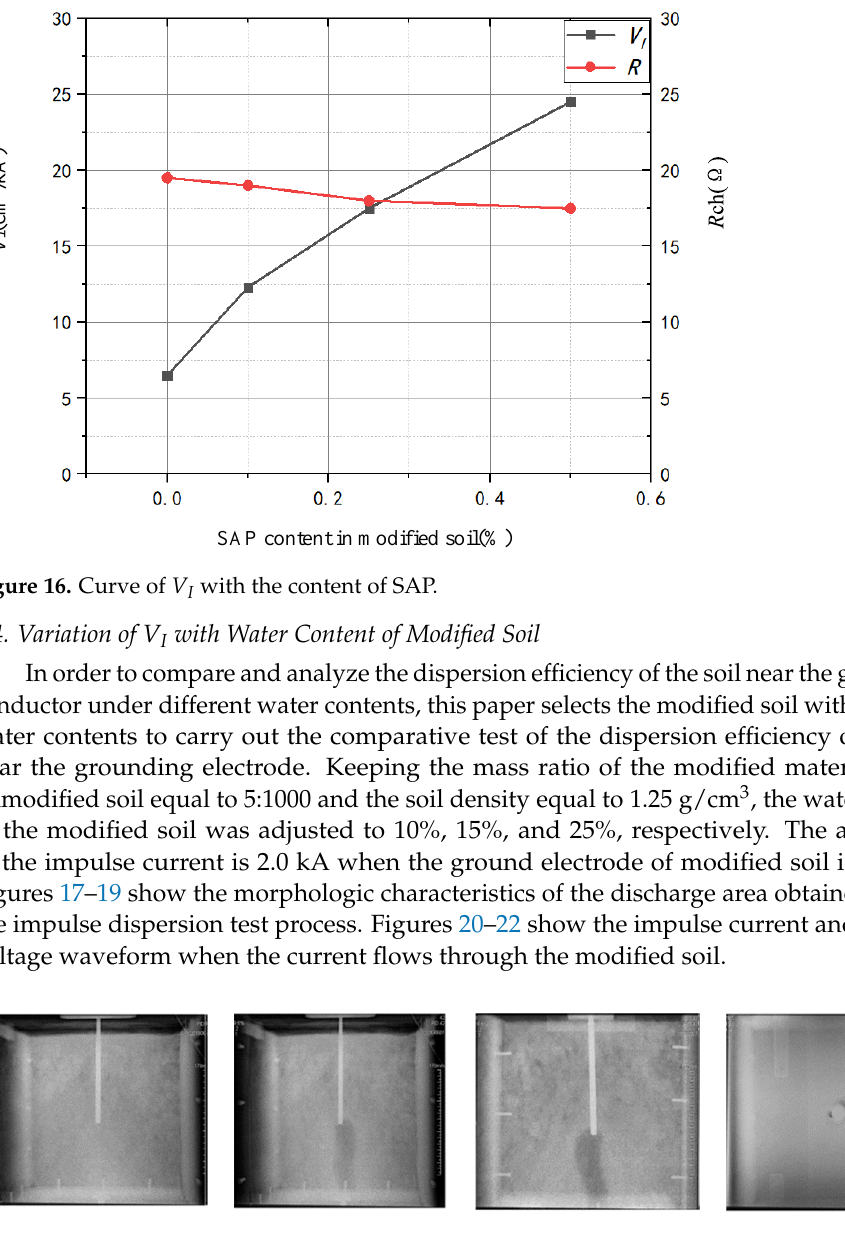
( d ) Figure 18. Images of modified soil with water content of 15%: ( a ) Before breakdown; ( b ) front view; ( c ) side view; ( d ) top view. ( a ) ( d ) Figure 19. Images of modified soil with water content of 25%: ( a ) Before breakdown; ( b ) front view; ( c ) side view; ( d ) top view. C u rr e n t/ k A Time/μs